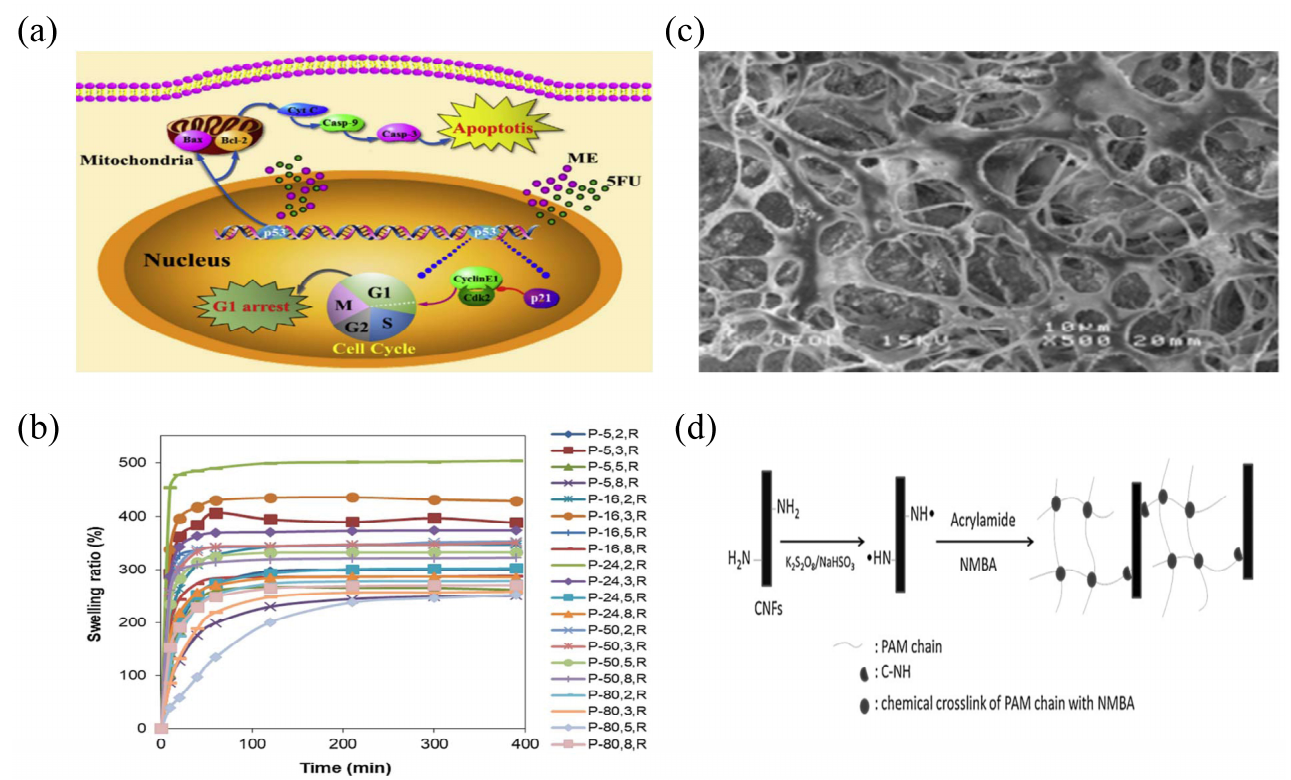
Figure 4. The action mechanism, swelling ratio, preparation flow chart, and internal structure diagram of some synthetic hydrogels. ( a ) The schematic illustration of synergistic antitumor effects of combination treatment of ME and 5FU released from the PFA/PPLL hydrogels. Reprinted with permission from Ref. [53]. Copyright 2016, Wu, X. ( b ) Swelling ratio of the dried PVA hydrogels at room temperature, pH 7.4. Reprinted with permission from Ref. [56]. Copyright 2021, Boran, F. ( c ) SEM image of PEO composite hydrogel. Reprinted with permission from Ref. [60]. Copyright 2019, Kanafi, N.M. ( d ) Schematic diagram of covalent bonding mechanism of PAM composite hydrogel. Reprinted with permission from Ref. [64]. Copyright 2011, Zhou, C.